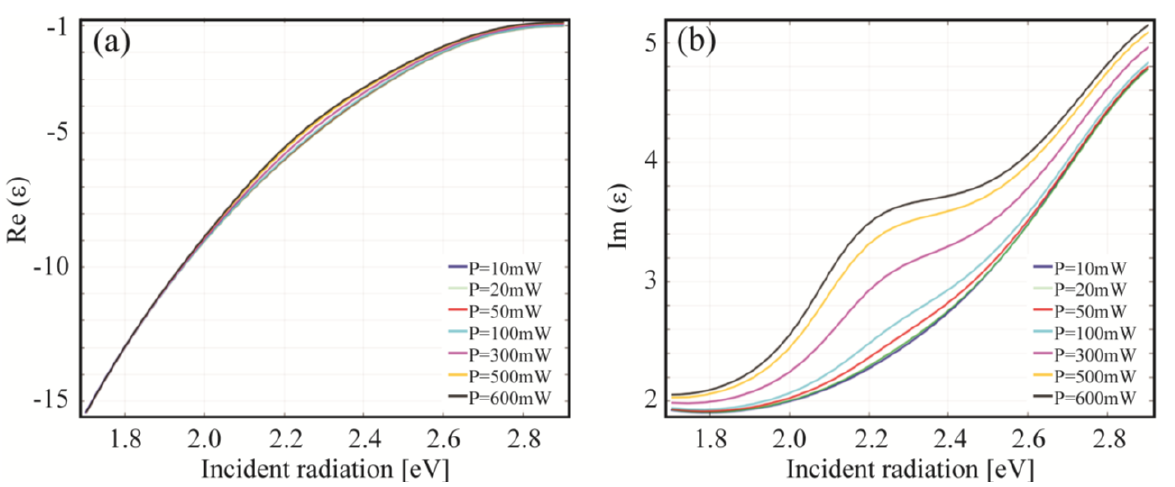
Figure 16. Power dependence of ( a ) the real and ( b ) imaginary part of the dielectric function (Equation (18)) for a gold nanosphere ( R = 10 nm) embedded in